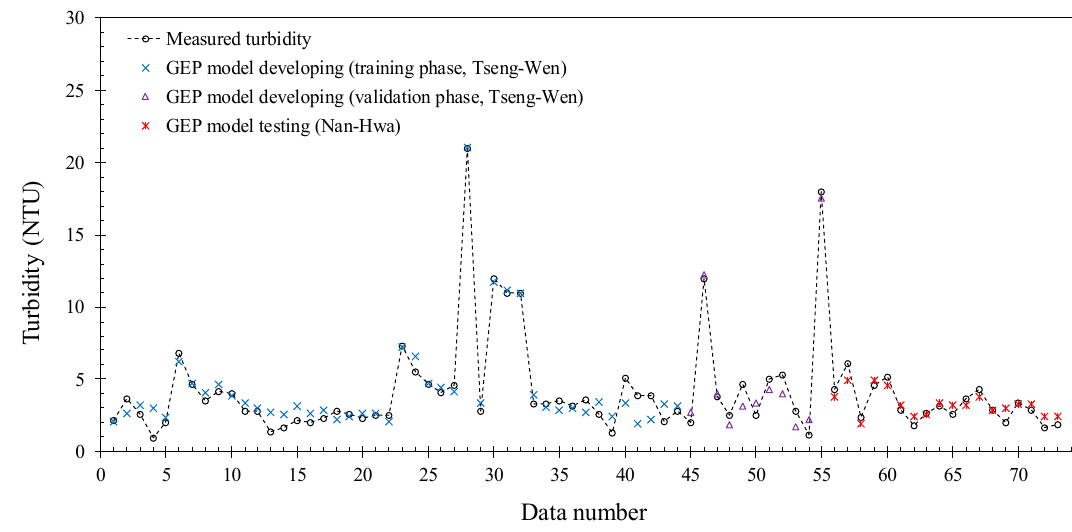
Figure 12. The relation of observed turbidity and gene-expression programming (GEP) simulated turbidity in Tseng-Wen and Nan-Hwa reservoir.